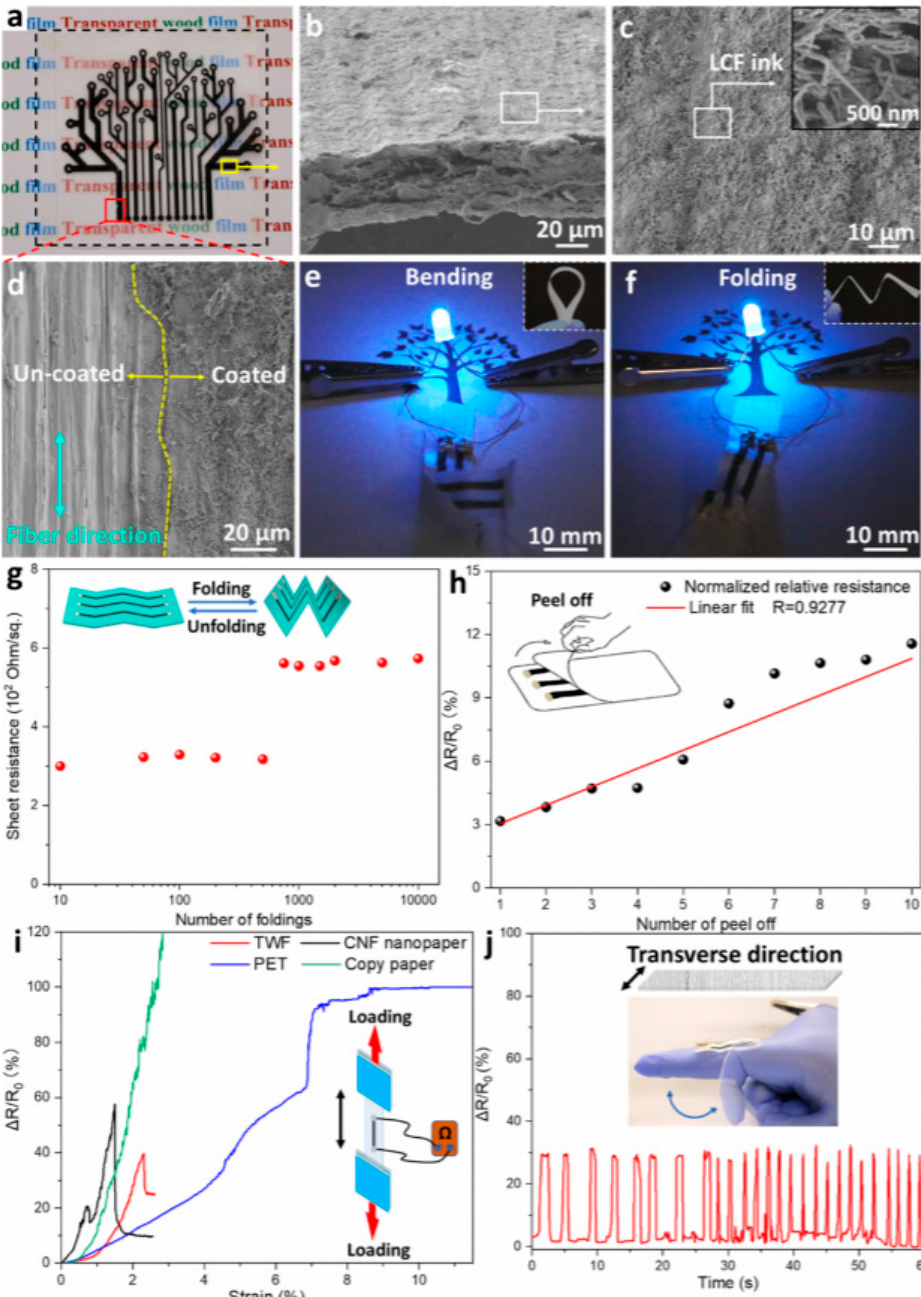
Figure 6. Performances of the thin wood substrate in terms of conductivity and flexibility. ( a ) Printed electronic circuit on the substrate. ( b ) and ( c ) Cross-sectional SEM view of the printed wood-derived ink. ( d ) SEM image on the edge of a printed track. LED put on for a bent ( e ) and a folded ( f ) substrate. ( g ) Sheet resistance of a printed track upon folding − unfolding cycles. ( h ) Resistance to repeated peel off. (i) Normalized relative resistance variation upon strain applied parallel to the fiber direction. ( j ) Normalized relative resistance variation upon repetitive 90° folding (resistance measured along the fiber direction). Reproduced from [56] with permission. Copyright © 2020 American Chemical Society.